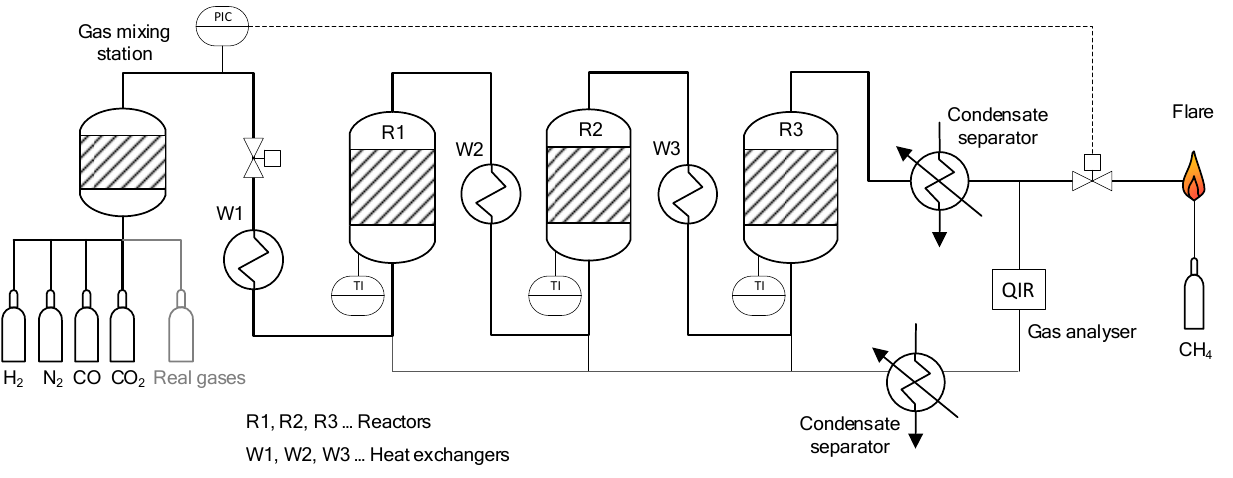
Figure 3. Simplified flowchart of MUL_CH4_TR [47].